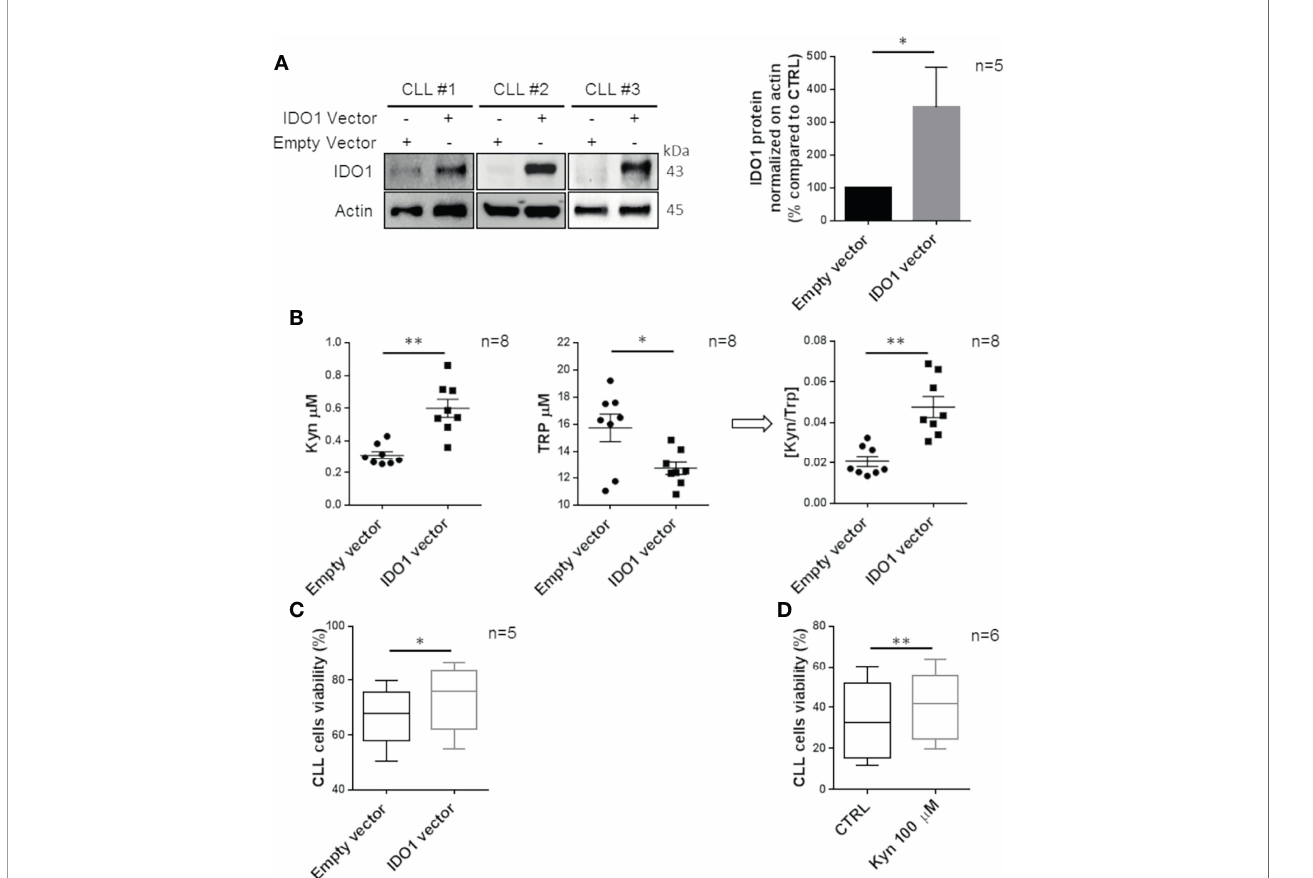
FIGURE 3 | CLL cell survival is promoted by IDO1 overexpression. (A) CLL cells were transfected with an IDO1-expressing vector or an empty vector. After 24h from transfection, the IDO1 protein level was measured by Western blot. Bar diagrams represent the densitometric quanti fi cations of IDO1 (Student paired t test, *p <